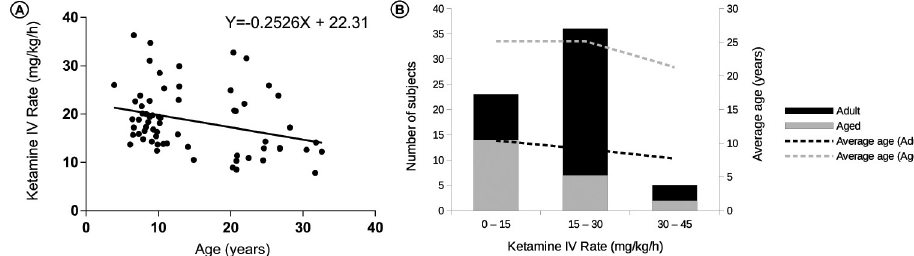
Fig 2. A. Correlation of ketamine IV infusion rate for light sedation with age. The ketamine infusion rate for achieving an equal plane of light sedation in all subjects was negatively correlated with age (r = -0.30, P < 0.05, n = 64). B. Separation of adult and aged subjects based on low, moderate, and high rates of ketamine infusion to achieve a light plane of sedation. Ketamine was administered at 0–15 mg/kg/hr in 9 adult and 14 aged subjects, at 15–30 mg/kg/hr in 29 adult and 7 aged subjects, and at 30–45 mg/kg/hr in 3 adult and 2 aged subjects, supporting findings of a negative correlation for ketamine infusion rate with age.